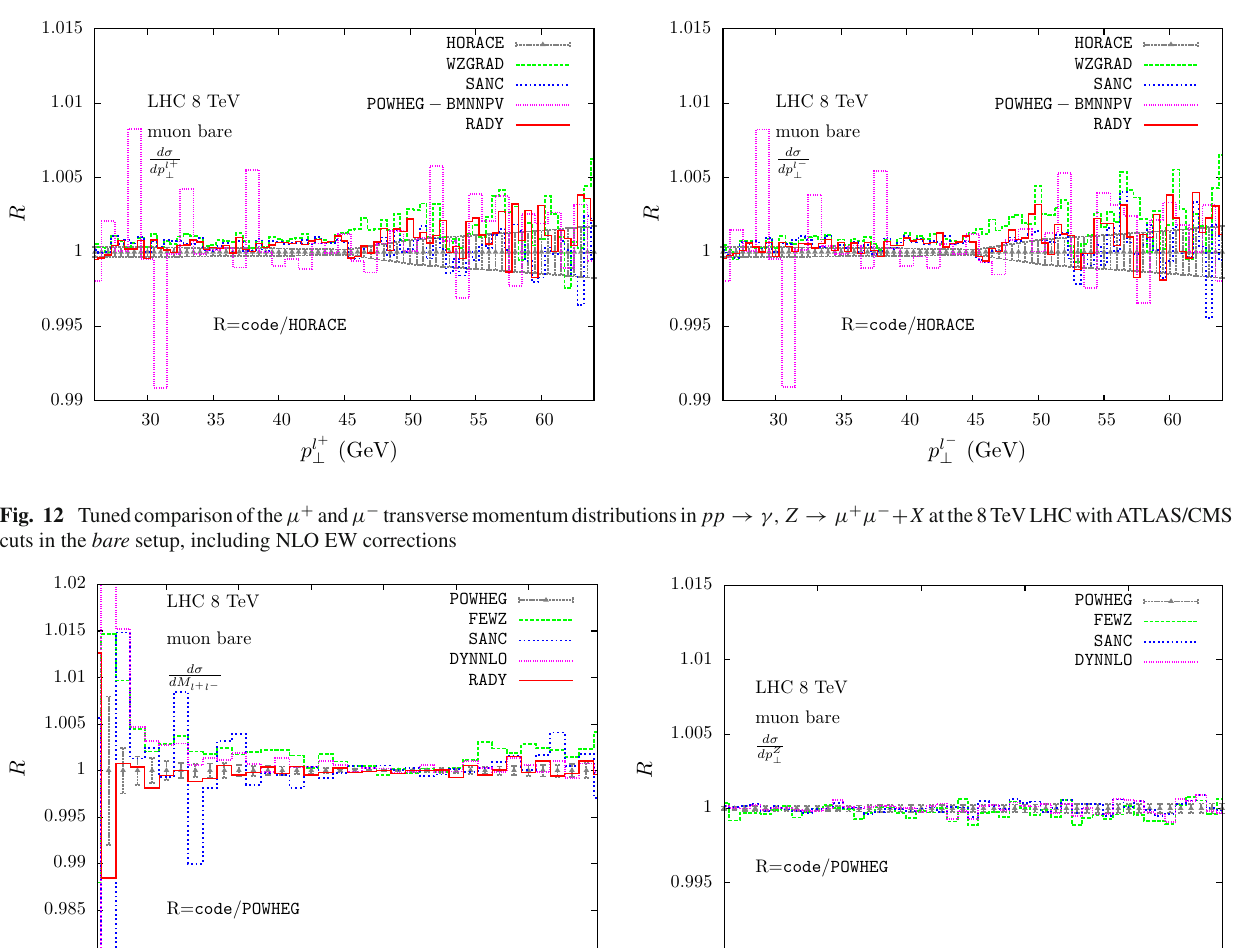
Fig. 11 Tuned comparison of the lepton-pair invariant mass and transverse momentum distributions in pp → γ, Z → μ + μ − + X at the 8 TeV LHC with ATLAS/CMS cuts in the bare setup, including NLO EW corrections